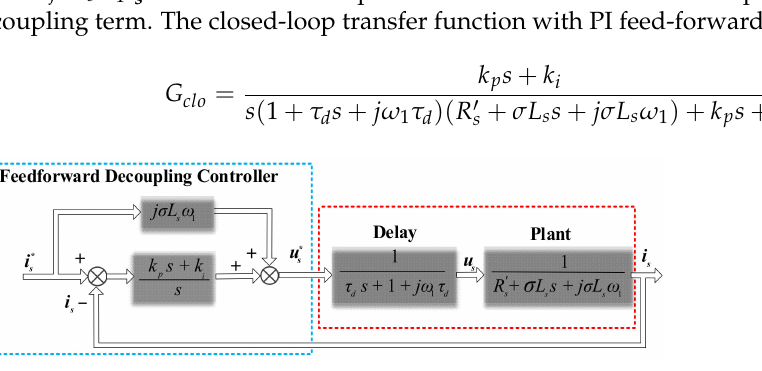
Figure 7. Feed-forward current controller block